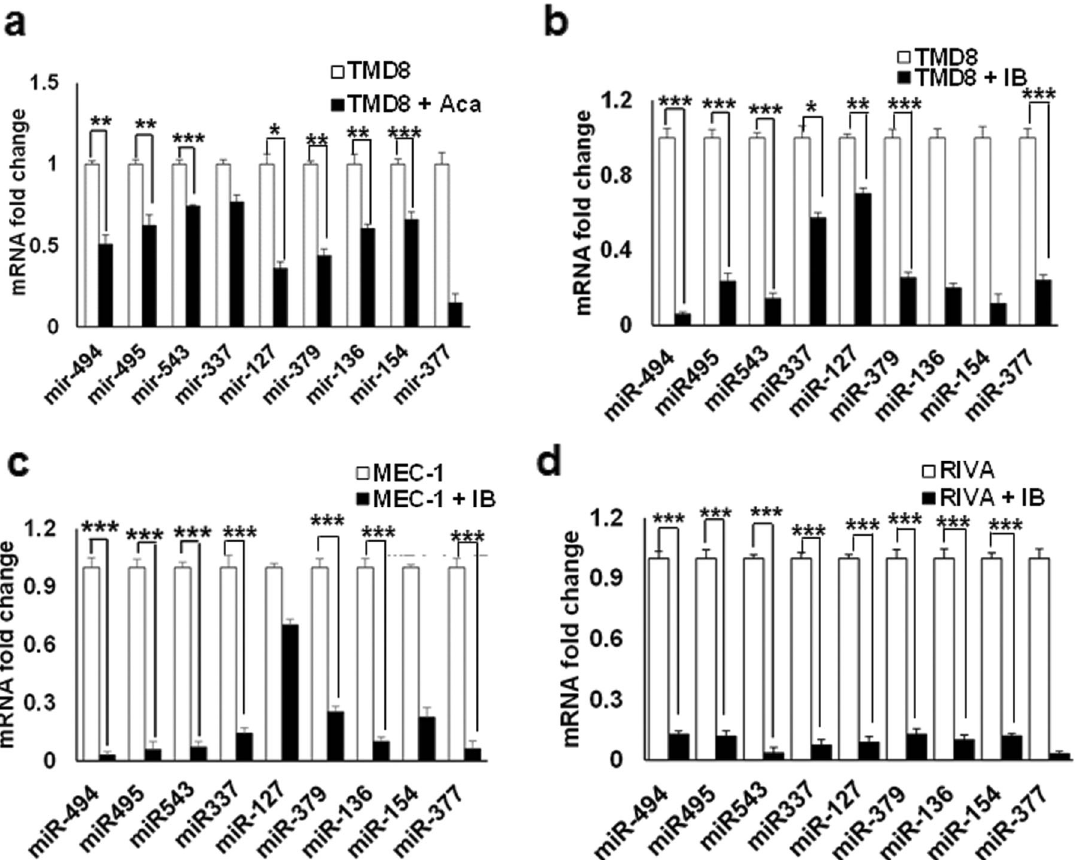
is normalized to untreated cells. b – d Relative expression changes of nine miRNAs in the 14q32 cluster, as determined by qRT-PCR in TMD8, MEC-1, and RIVA cells treated with ibrutinib (10 µM) for 48 h. miRNAs fold change in ibrutinib-treated cells